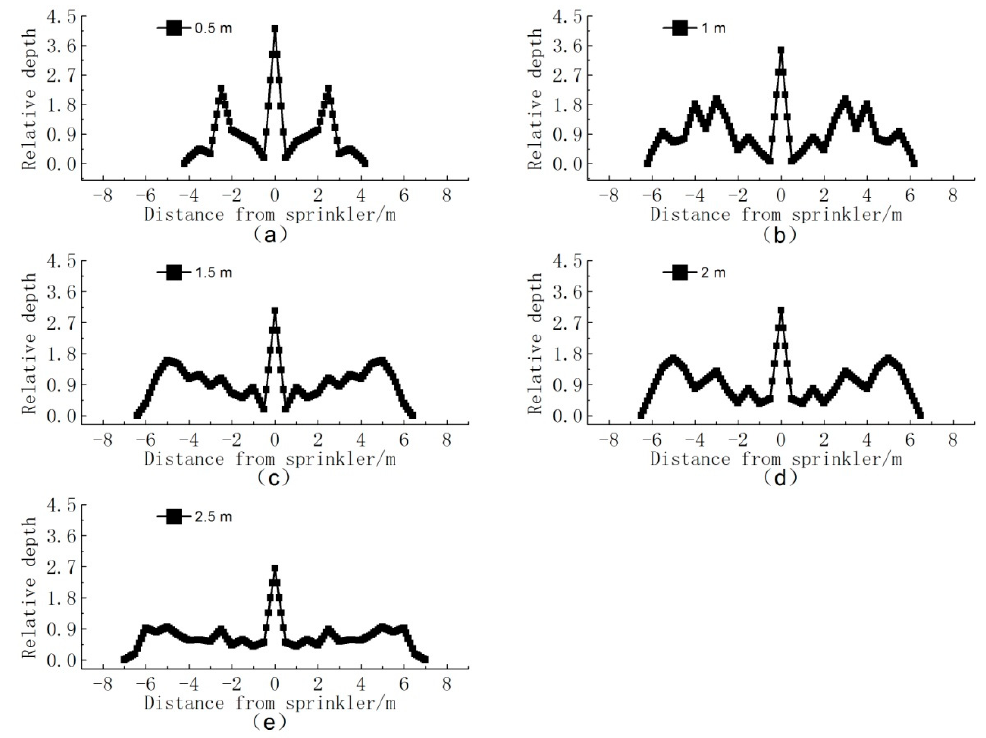
Figure 11. Calculated relative water depths for an in-motion sprinkler with a working pressure of 100 kPa and different mounting heights: ( a ) 0.5 m, ( b ) 1 m, ( c ) 1.5 m, ( d ) 2 m, and ( e ) 2.5 m. (2) Wetted